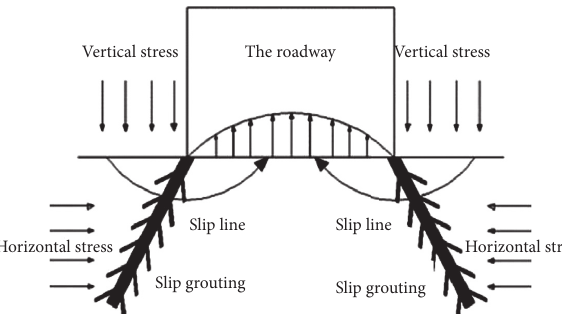
Figure 2: The support mechanism of floor corner pile.